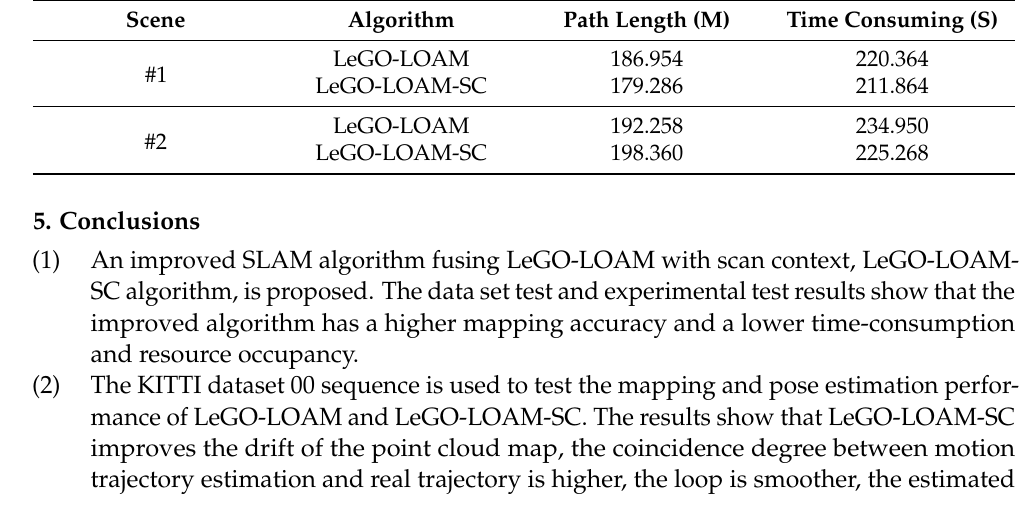
Table 4. Track length and